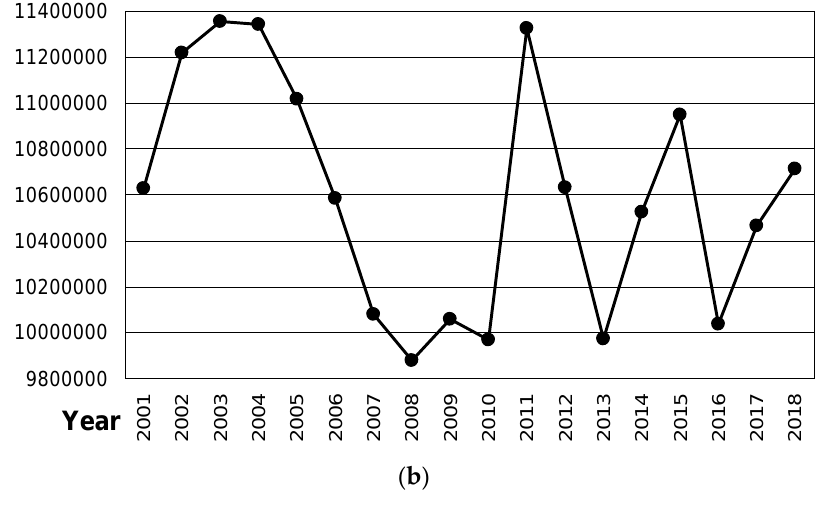
Figure 10. Dynamic of the existing ( a ) and functional ( b ) tourism capacity on the Romanian seaside during 1990–2018. The existing capacity represents the actual accommodation capacity as provided in the authorization of each tourism unit. The functional tourism capacity is computed as the product of the number of available seats and the number of days when the units are actually open. Source of data: Romanian Statistical Yearbooks (National Institute for Statistics). Data cover the existing capacity for 1990–2018 and functional capacity for 2001–2018.